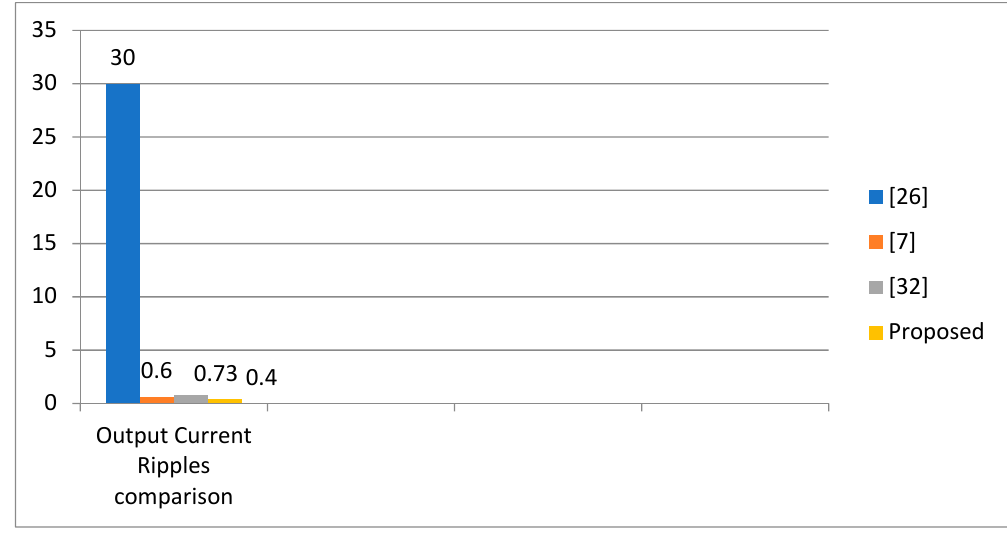
Figure 37. Current ripples magnitude comparison.